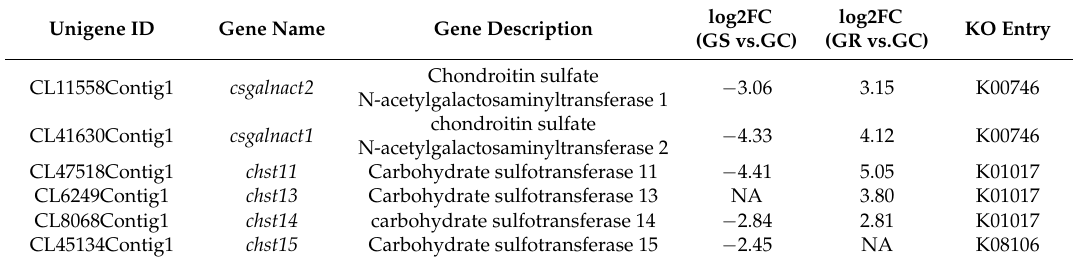
Table 3. The differentially expressed genes involved in glycosaminoglycan biosynthesis.